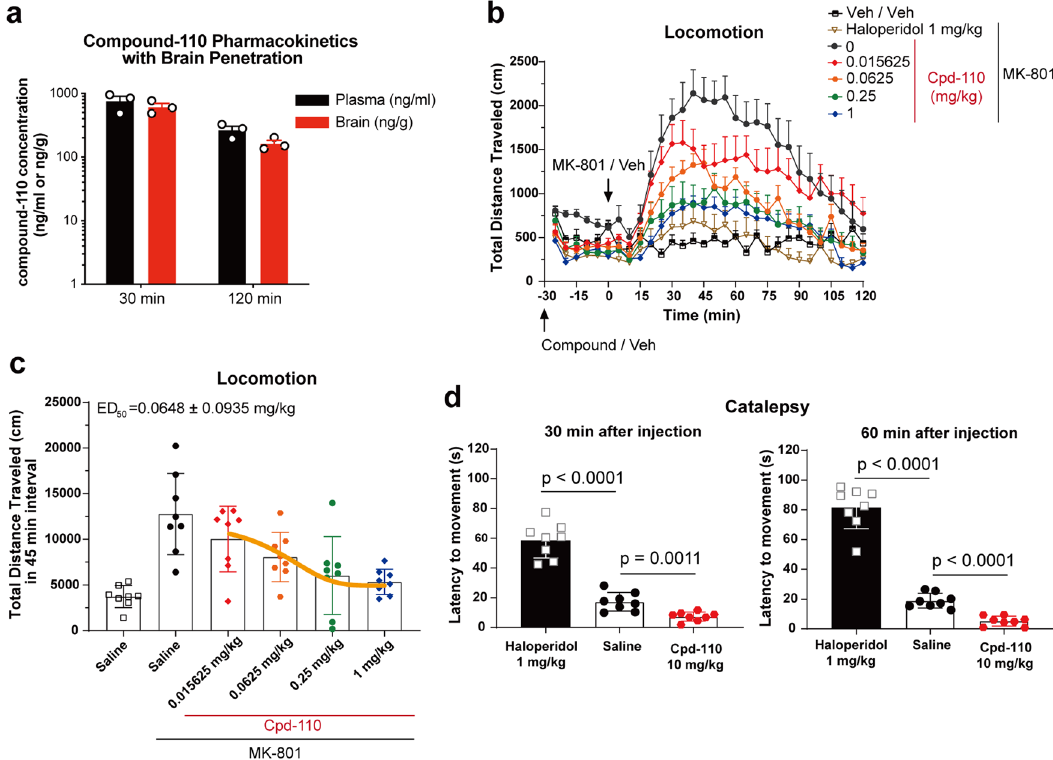
Fig. 5 Compound-110 reverses MK-801-induced hyperlocomotion without inducing catalepsy. a Brain penetration of compound-110 in mice ( n = 3) after 1 mg/kg compound-110 intraperitoneally (i.p.) administration. b i.p. administration of compound-110 dose-dependently reverses MK-801-induced hyperlocomotion. c The median effective dose (ED 50 ) of compound-110 is calculated from total traveled distance in 0 – 45 min interval in a after MK-801 administration using ‘ one-phase-exponential decay ’ method. d Compound-110 does not elicit recognizable catalepsy; haloperidol (1 mg/kg) is used as the positive control to elicit catalepsy as assessed by latency to movement, p -value is calculated using unpaired t -test. Data are shown as mean ± SEM of 8 animals per group in b – d . Source data are provided as a Source Data fi